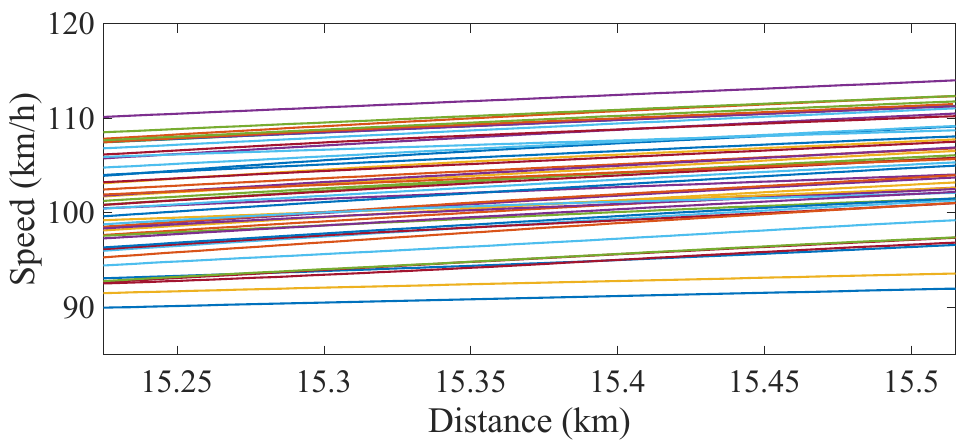
Figure 12. Speed of the train runs on the bridge-the distance on the X axis is from a reference point about 15 km before the bridge.